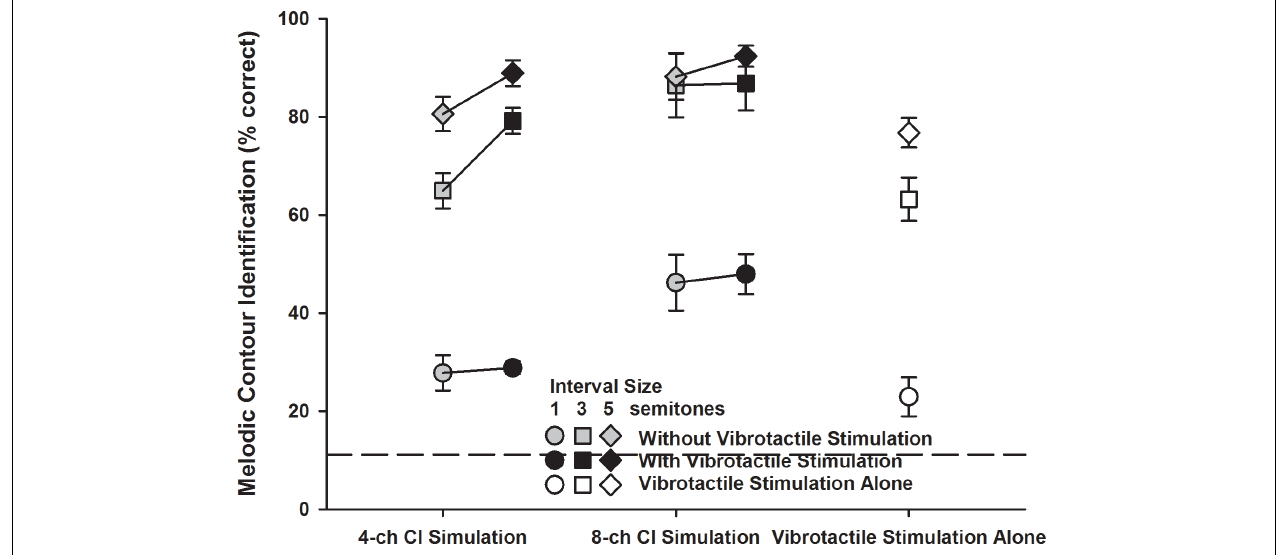
FIGURE 6 | Melodic contour identification scores for the 1-, 3-, and 5-semitone intervals (circles, squares, and diamonds, respectively) with the 4- or 8-channel CI simulation (left and middle line plots, respectively) with or without vibrotactile stimulation (black and gray symbols, respectively) or with vibrotactile stimulation alone (white symbols). Symbols represent the mean, while error bars represent the standard error across participants. The horizontal dashed line indicates the chance performance of 11%